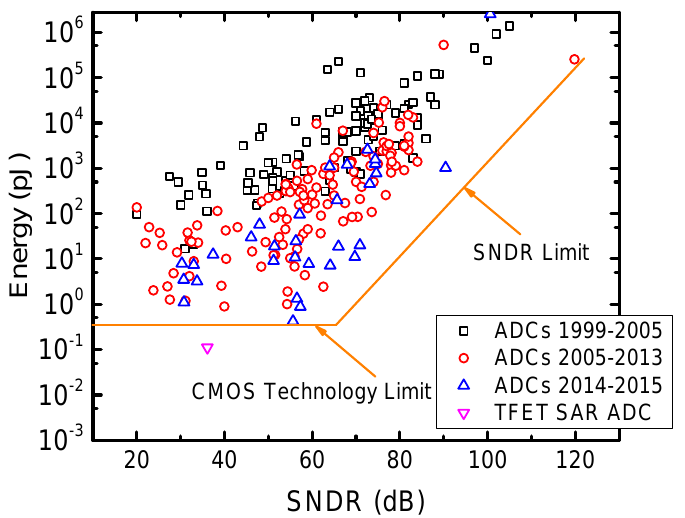
Figure 23. Simulated effective number of bits of SAR ADCs versus supply voltage.